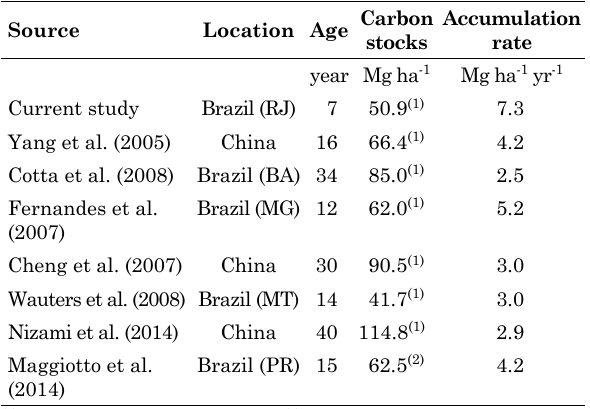
Table 6. Average tree carbon stocks in the biomasses of different rubber